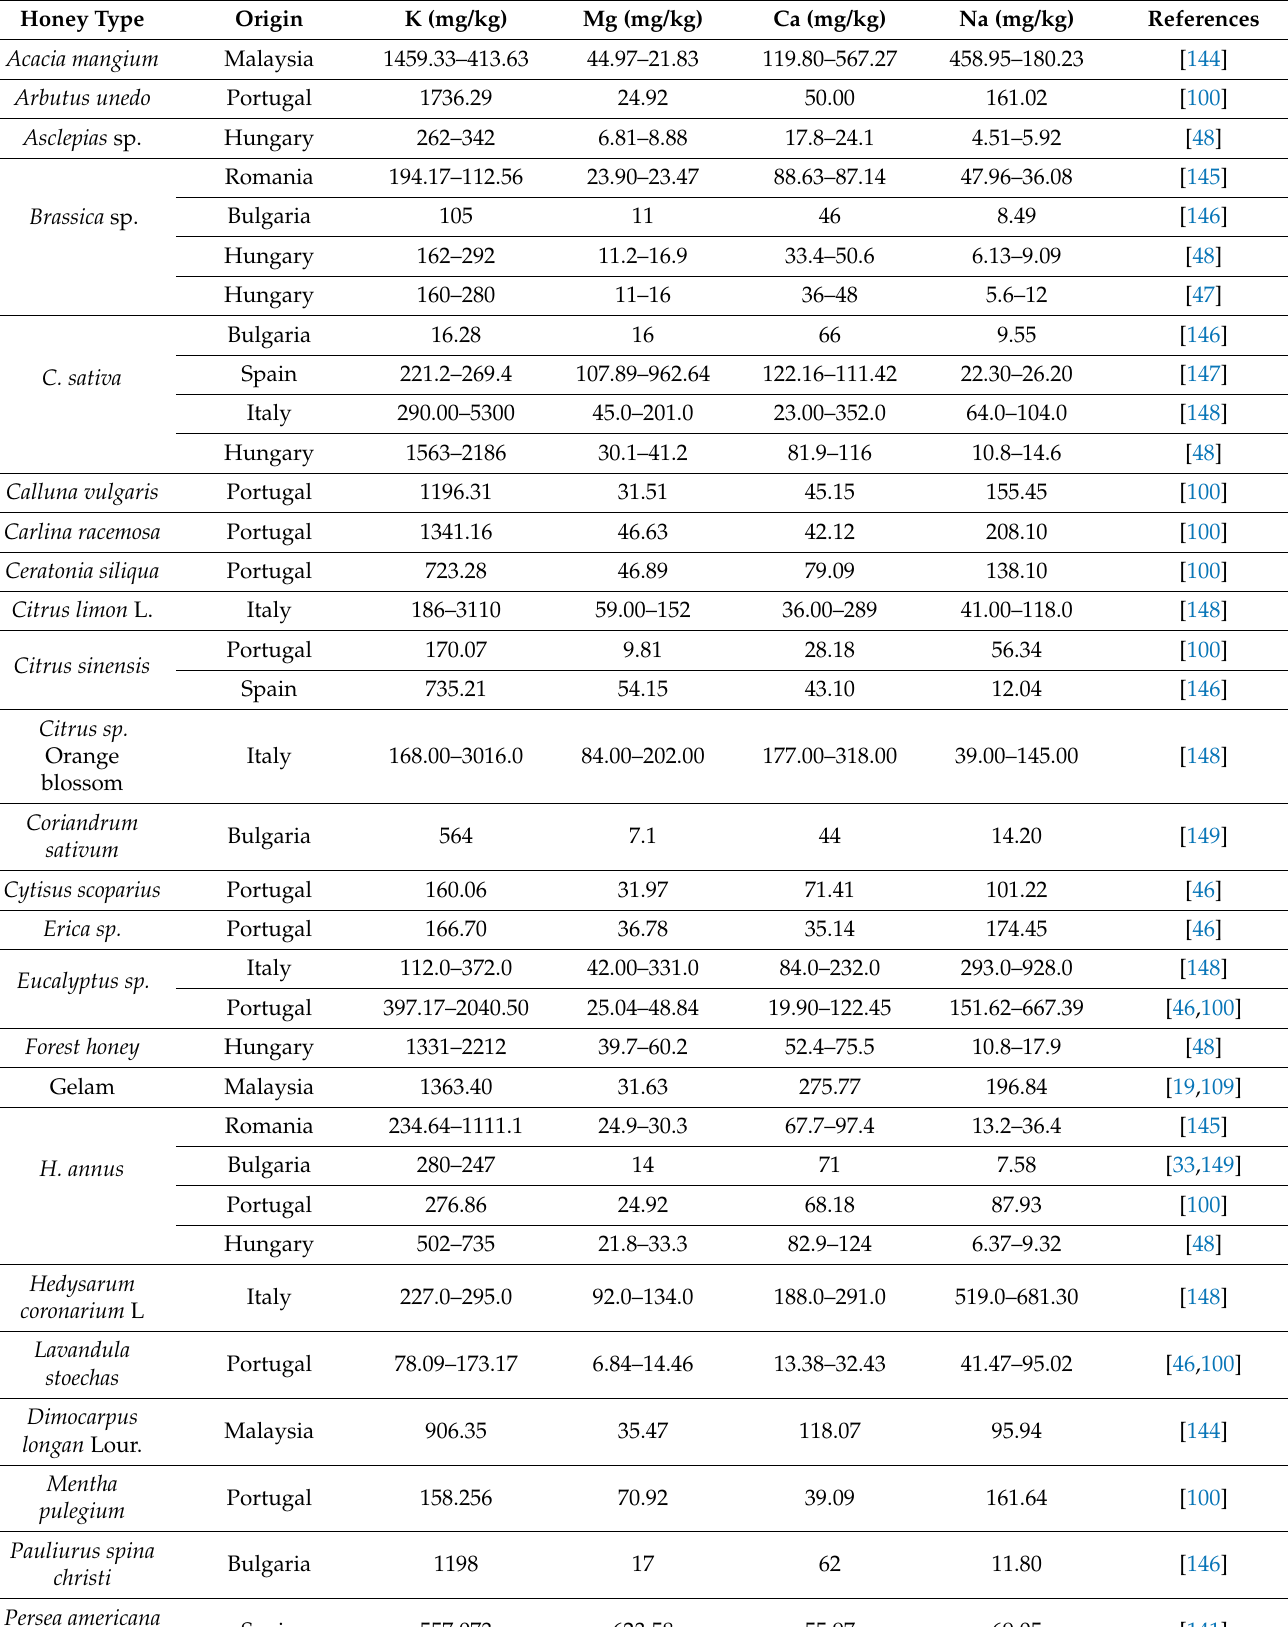
Table 4. Monofloral honeys mineral content from different